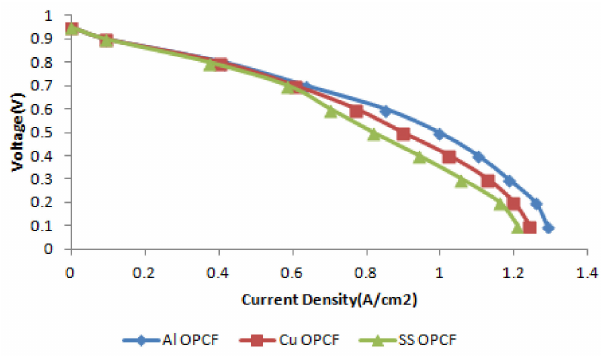
Figure 6. Hydrogen humidification temperature 80 ◦